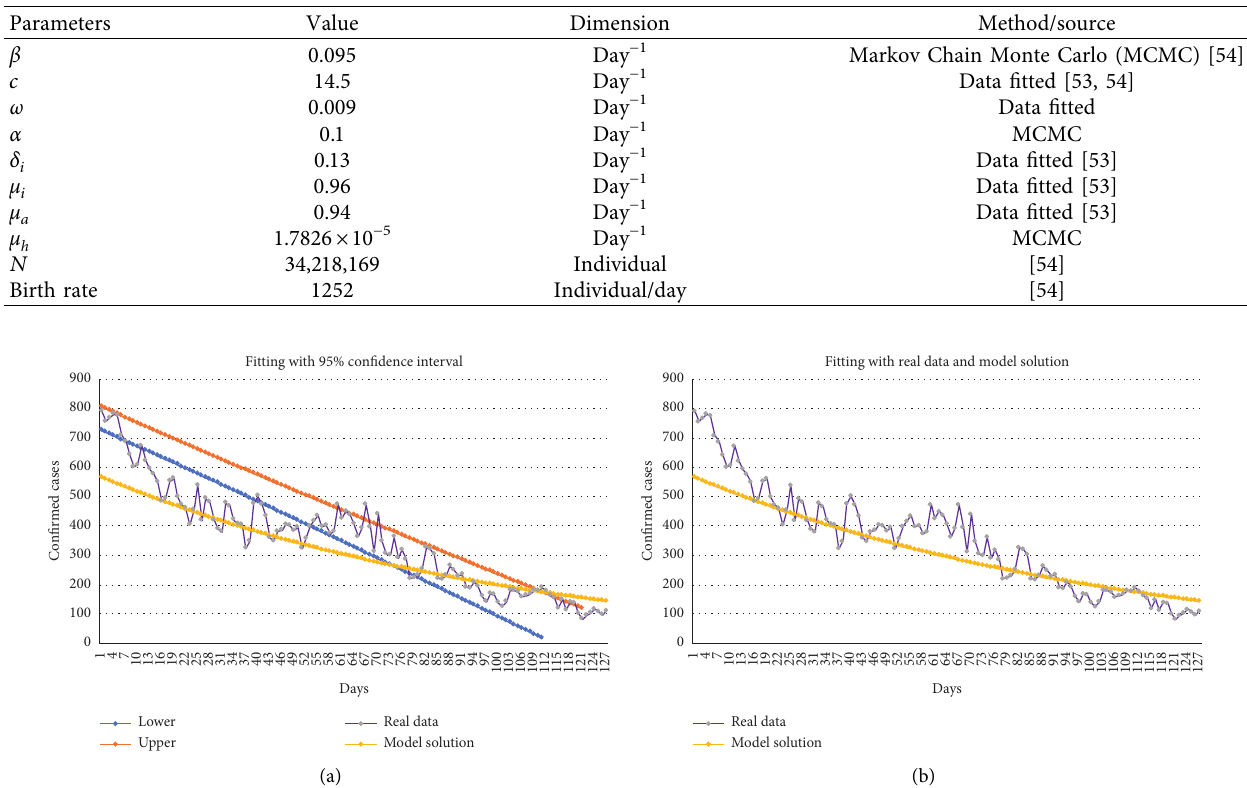
Table 6: Estimated values of parameters.